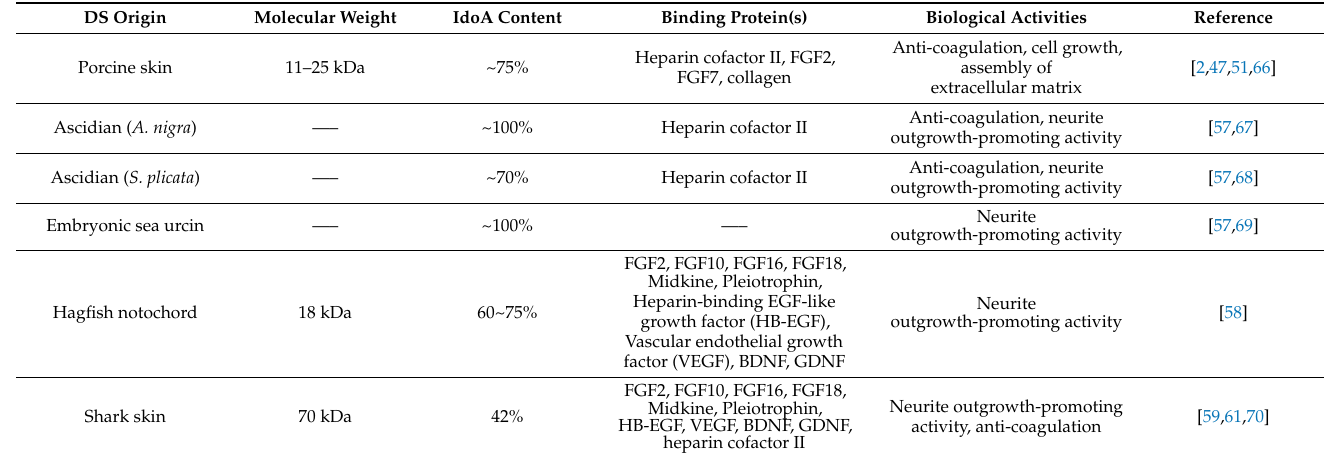
Table 1. Biological activities of a variety of DS